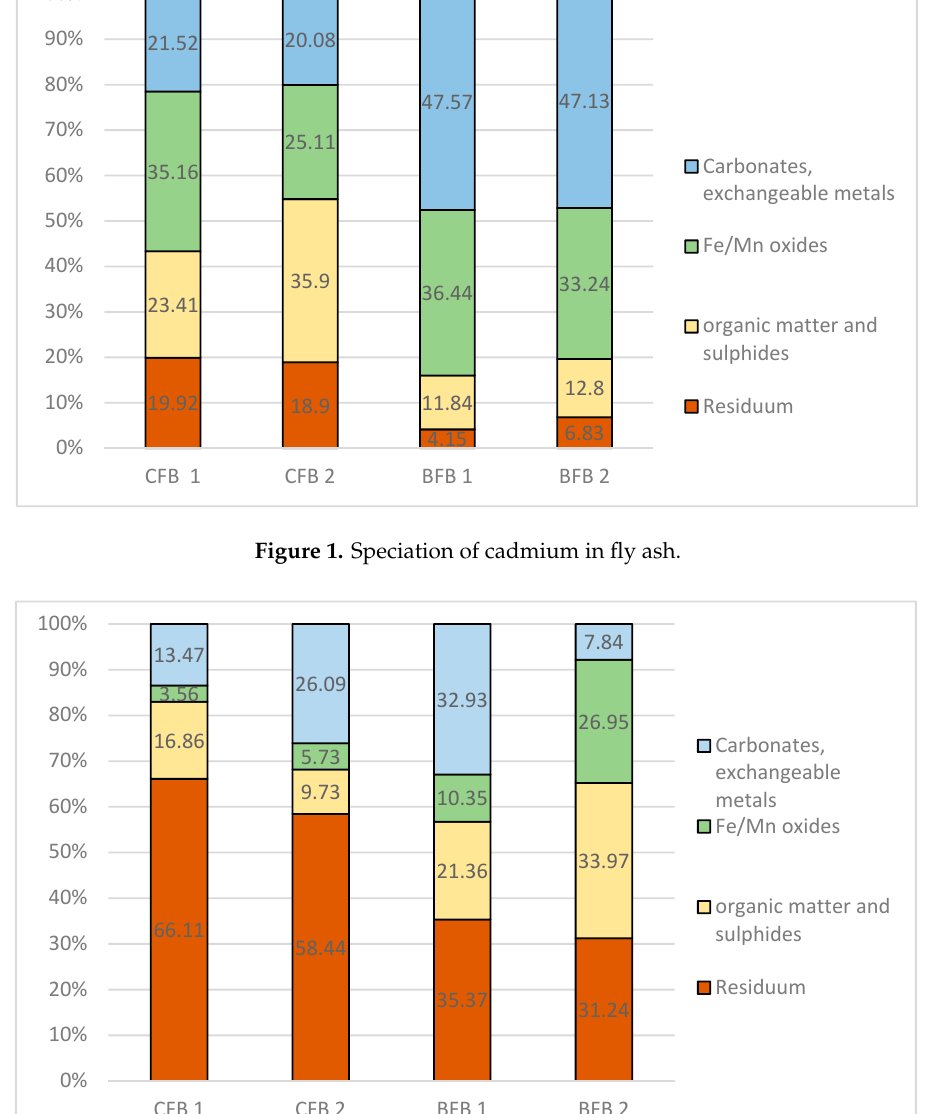
Figure 3. Speciation of Zn in fly ash.